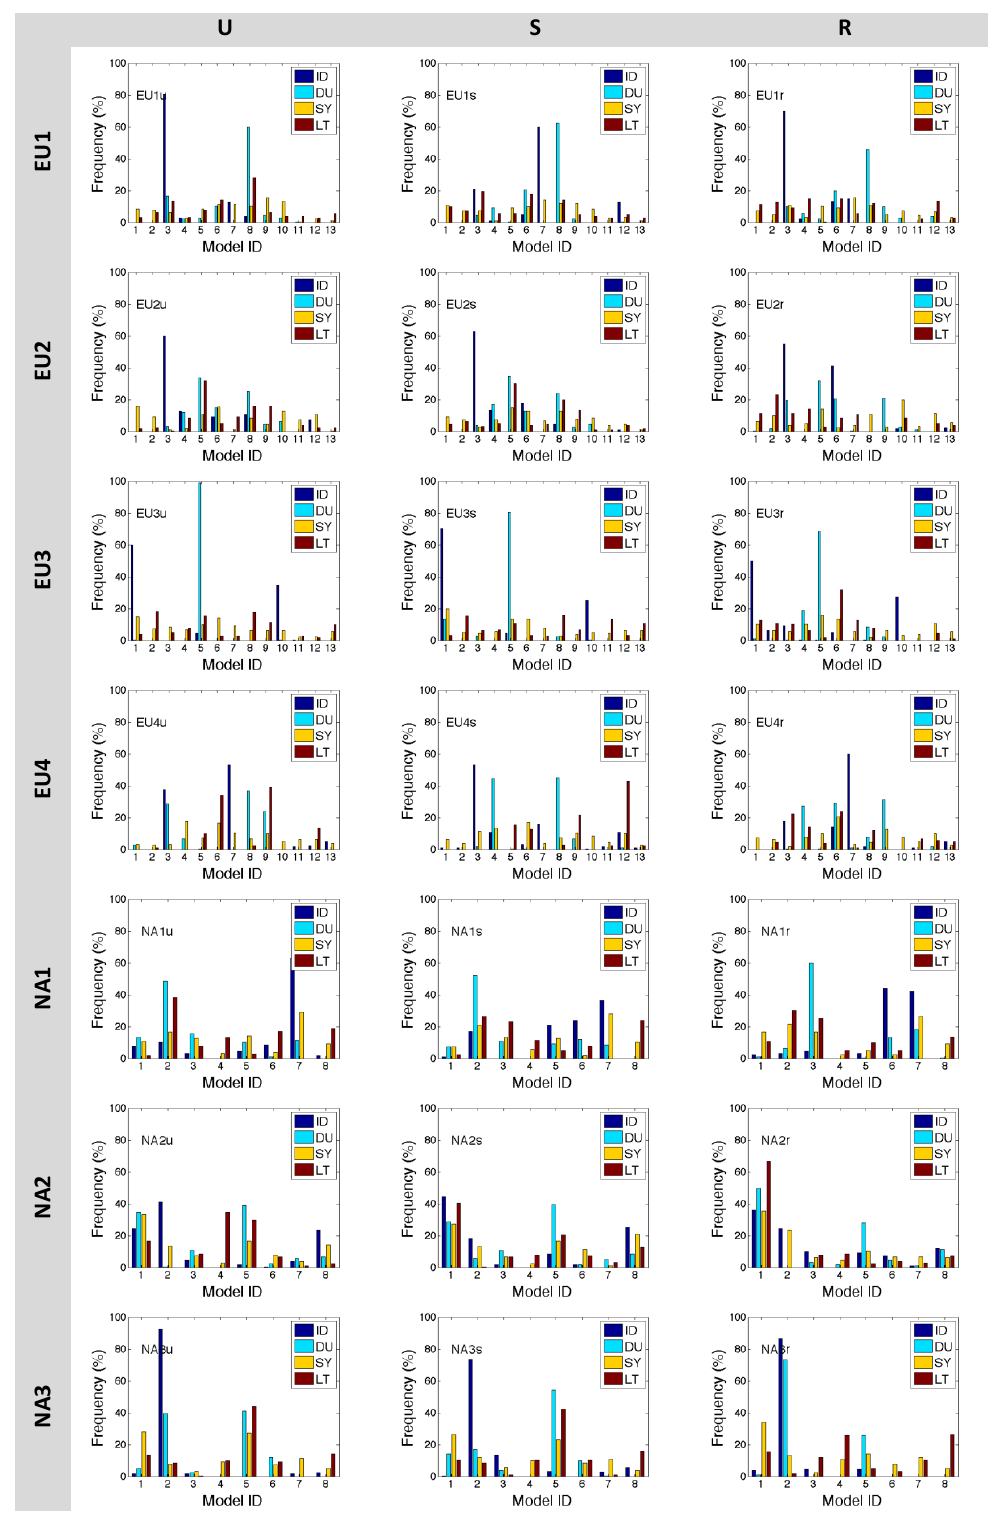
Fig. 11. The frequency of selection of each model’s spectral components as elements of the kz model, for all seven subdomains and three ozone aggregation types. Generally, a couple of models dominate into the ID and DU components while the SY and LT components of the kz model make use of nearly all the ensemble